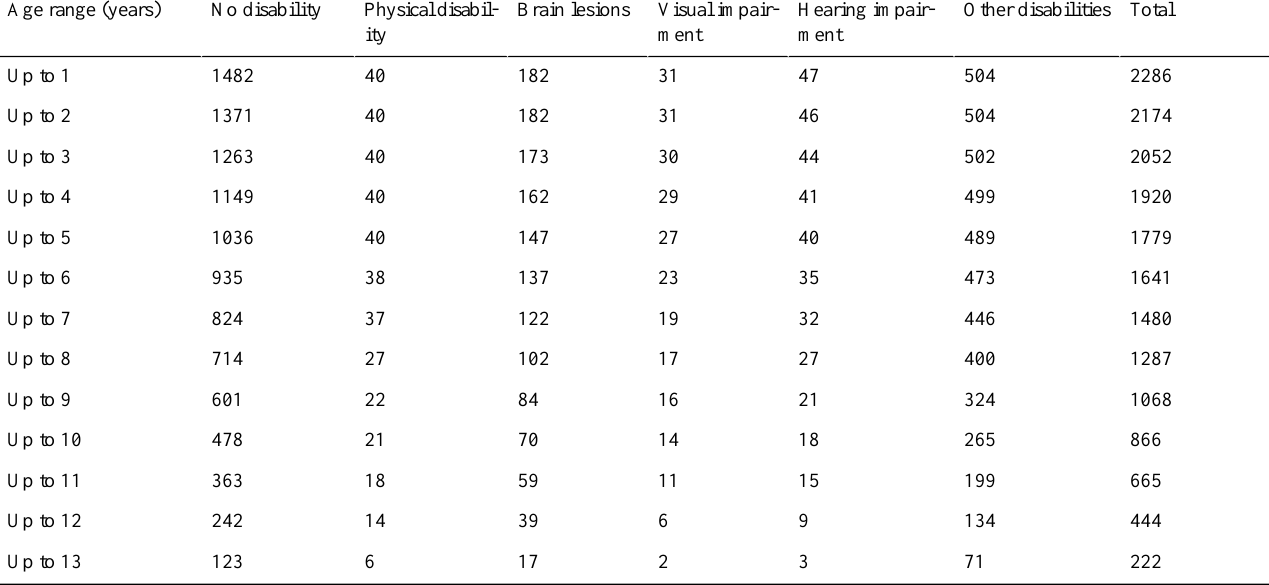
Table 1. Data samples by age